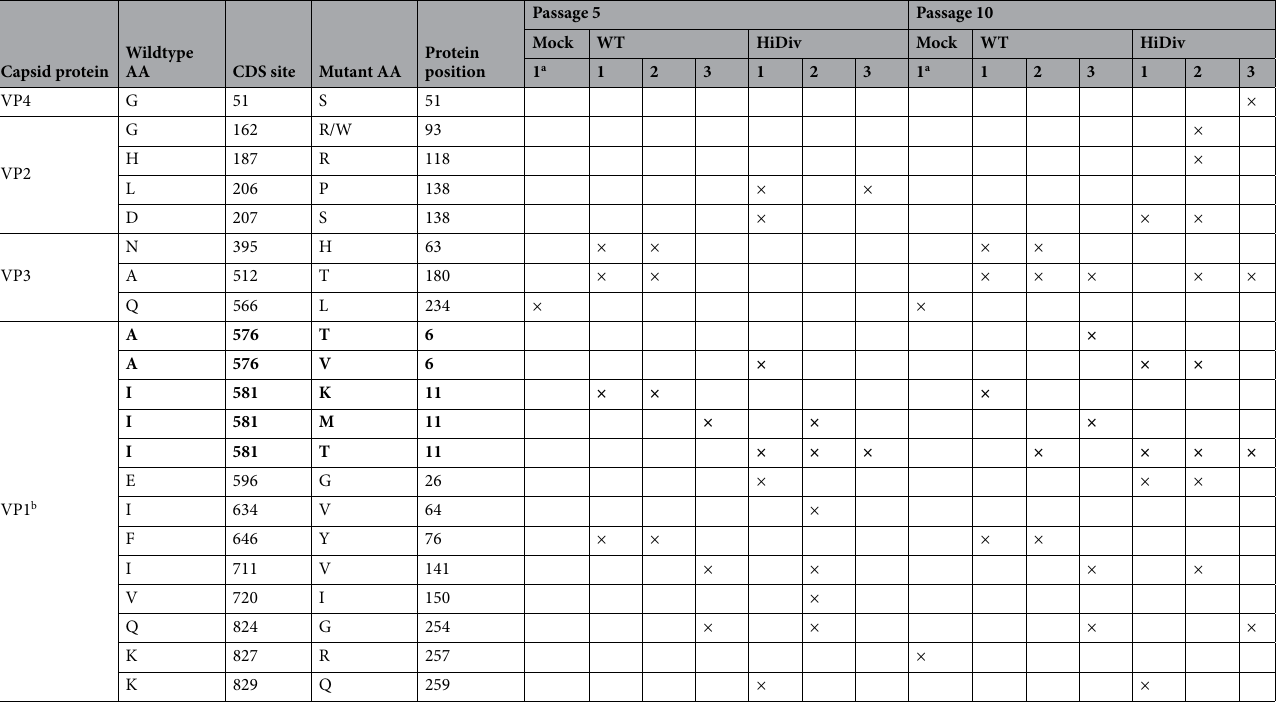
Table 1. The high-frequency mutations observed at passage 5 and 10 of the experimental evolution regime. a WT viral population passaged in HeLa-H1 cells without heat treatment. b Bold font indicates positions where multiple non-synonymous mutations were